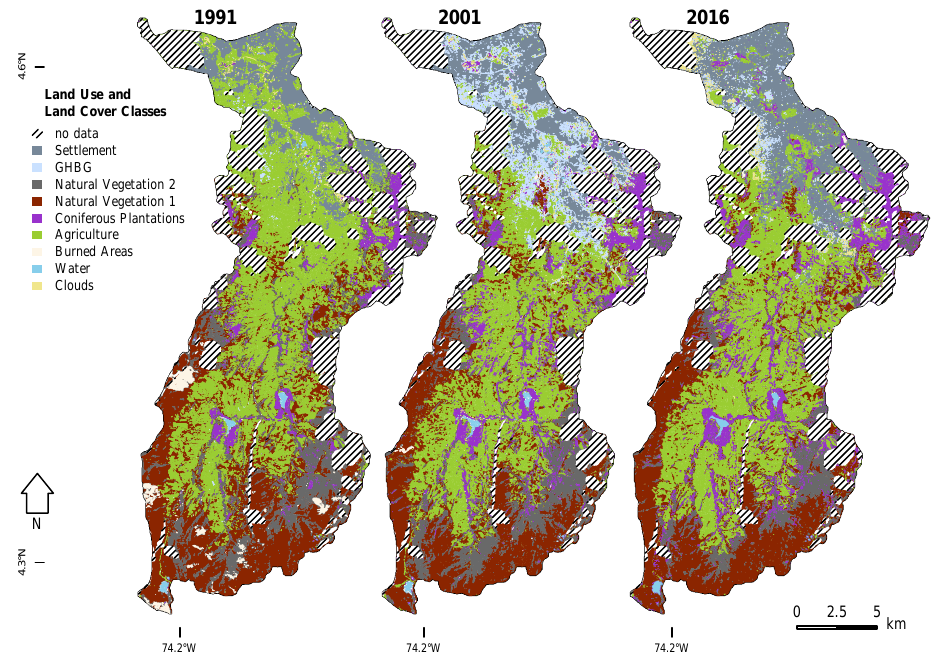
Figure 5. Land Cover of the Rio Tunjuelo basin south of Bogotá; in its lower course and close to its confluence with the Rio Bogotá the Rio Tunjuelo runs through the peri-urban area of Bogotá. The maps depict land use and land cover for the years 1991, 2001, and